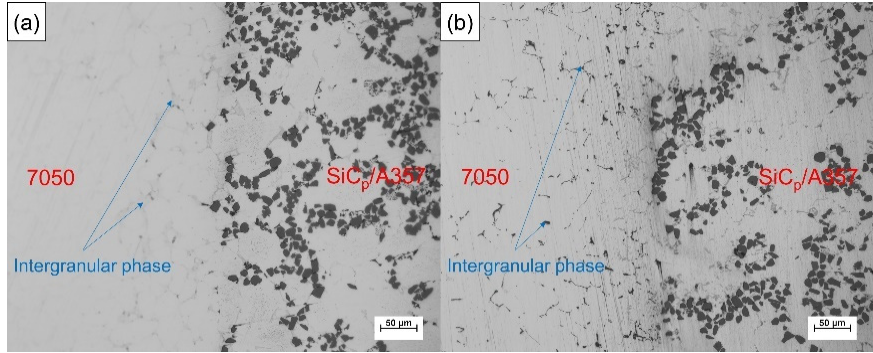
Figure 15. Optical metallography of the solid–liquid bonding interface in as-cast ( a ) and T6 ( b ) status.